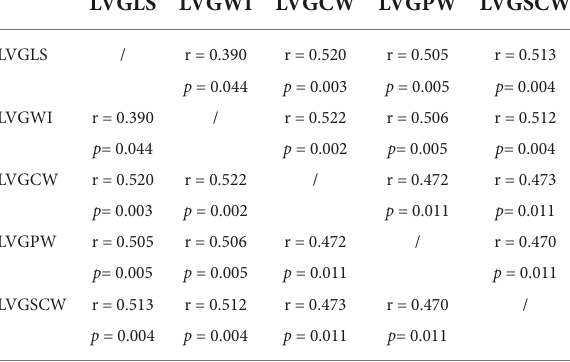
TABLE 5 Correlation analysis results between combination of STE-derived indices and left ventricular stroke work